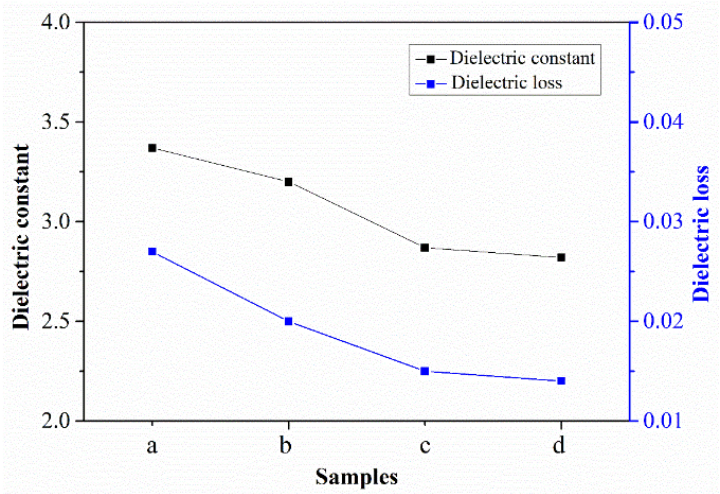
Figure 9. Dielectric properties of PEN–OH films.